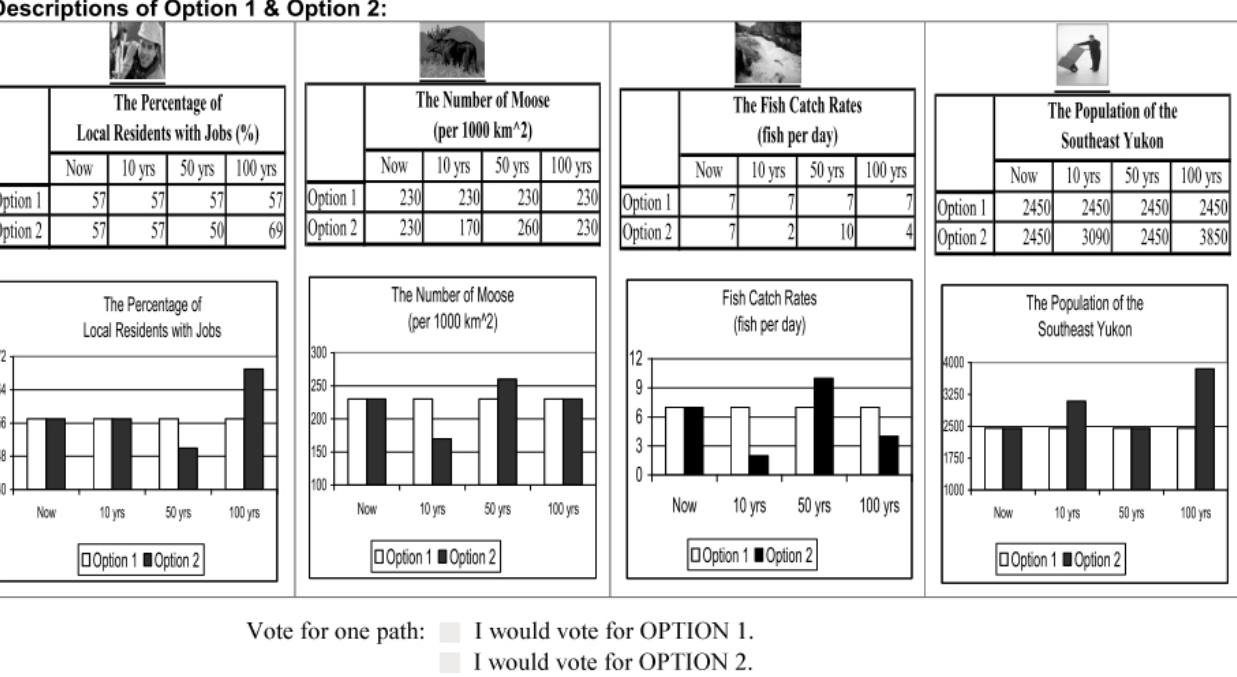
Fig. 1 . Illustration of the Choice Task